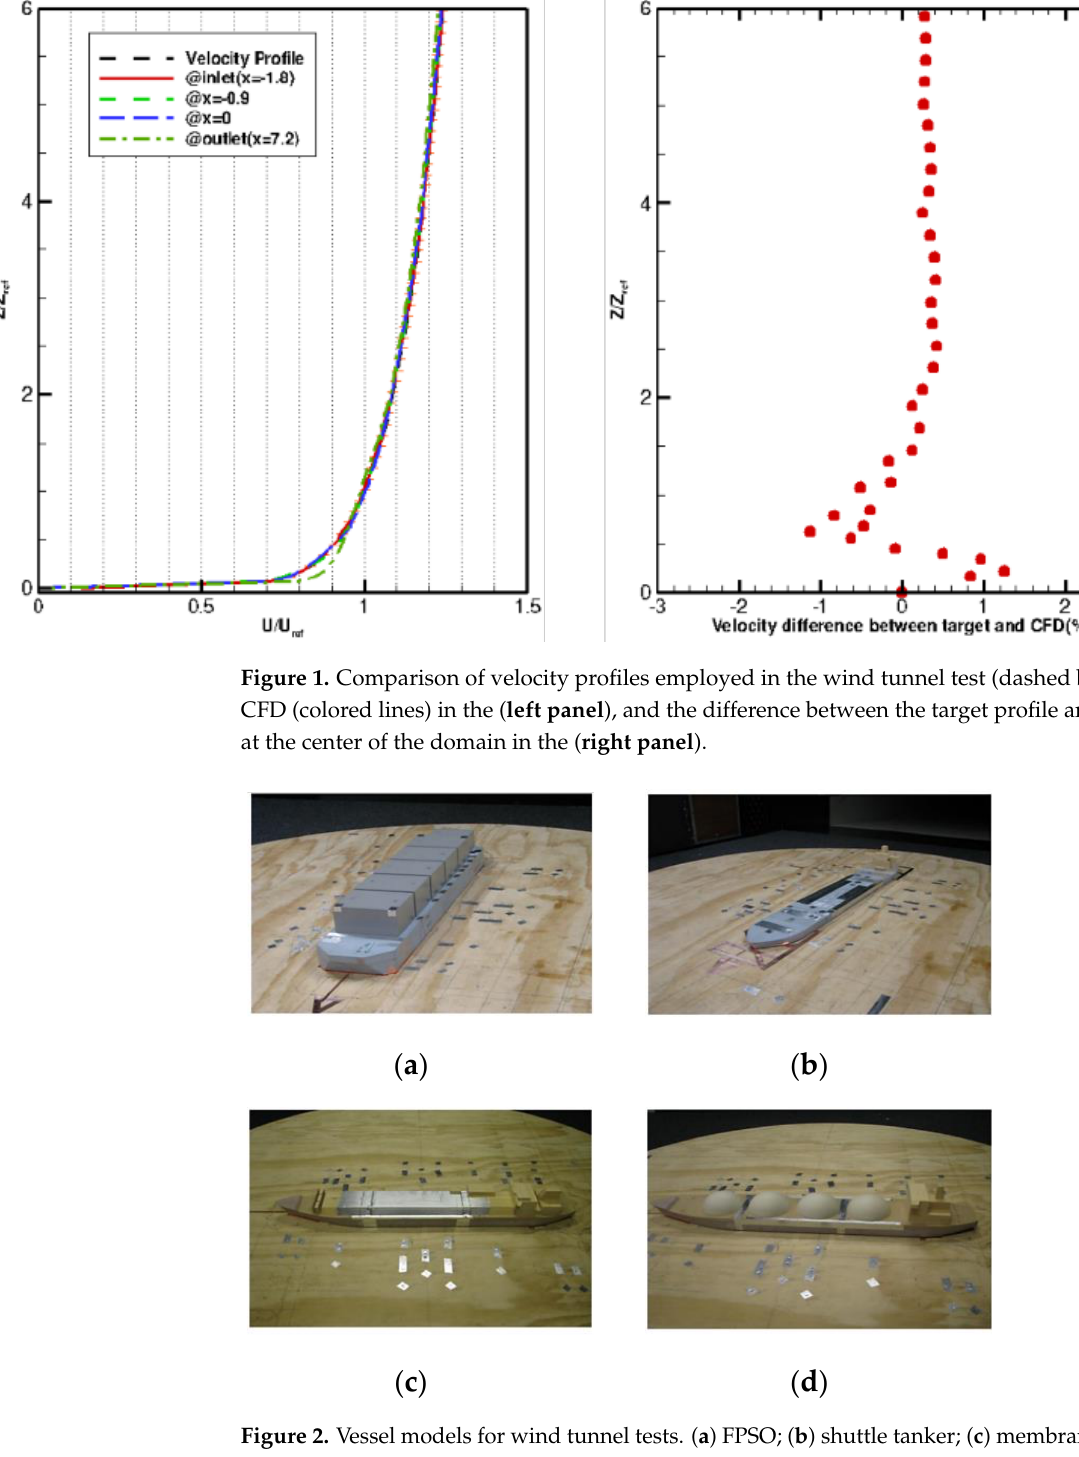
( b ) Figure 3. Comparison of four wind tunnel tests of moss-type LNGC. Schemes follow the same for- matting. ( a ) Measured x-force coefficients; and ( b ) trend lines. Table 1. Experimental uncertainty analysis for moss-type LNGC. Headings ( ° )